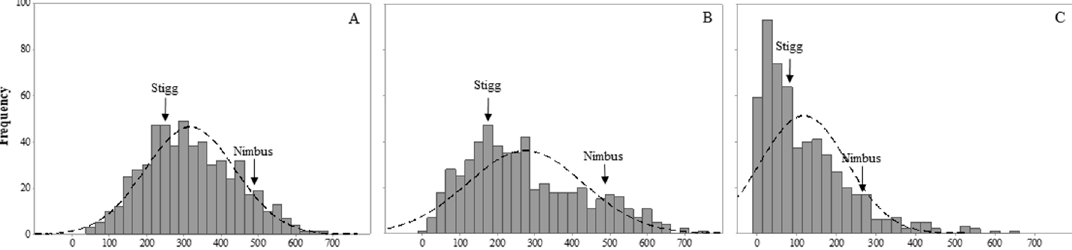
Figure 1. Phenotype distribution of area under disease progress curve (AUDPC) for STB disease ( A ) chlorosis (CHL), ( B ) necrosis (NEC), ( C ) pycnidia (PYC).